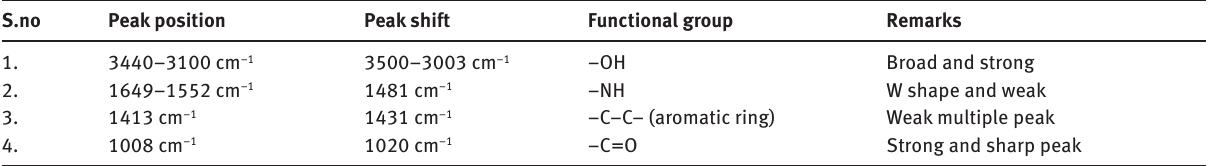
Table 1: Different functional groups in gaur gum and their shift caused by palladium nanoparticles.